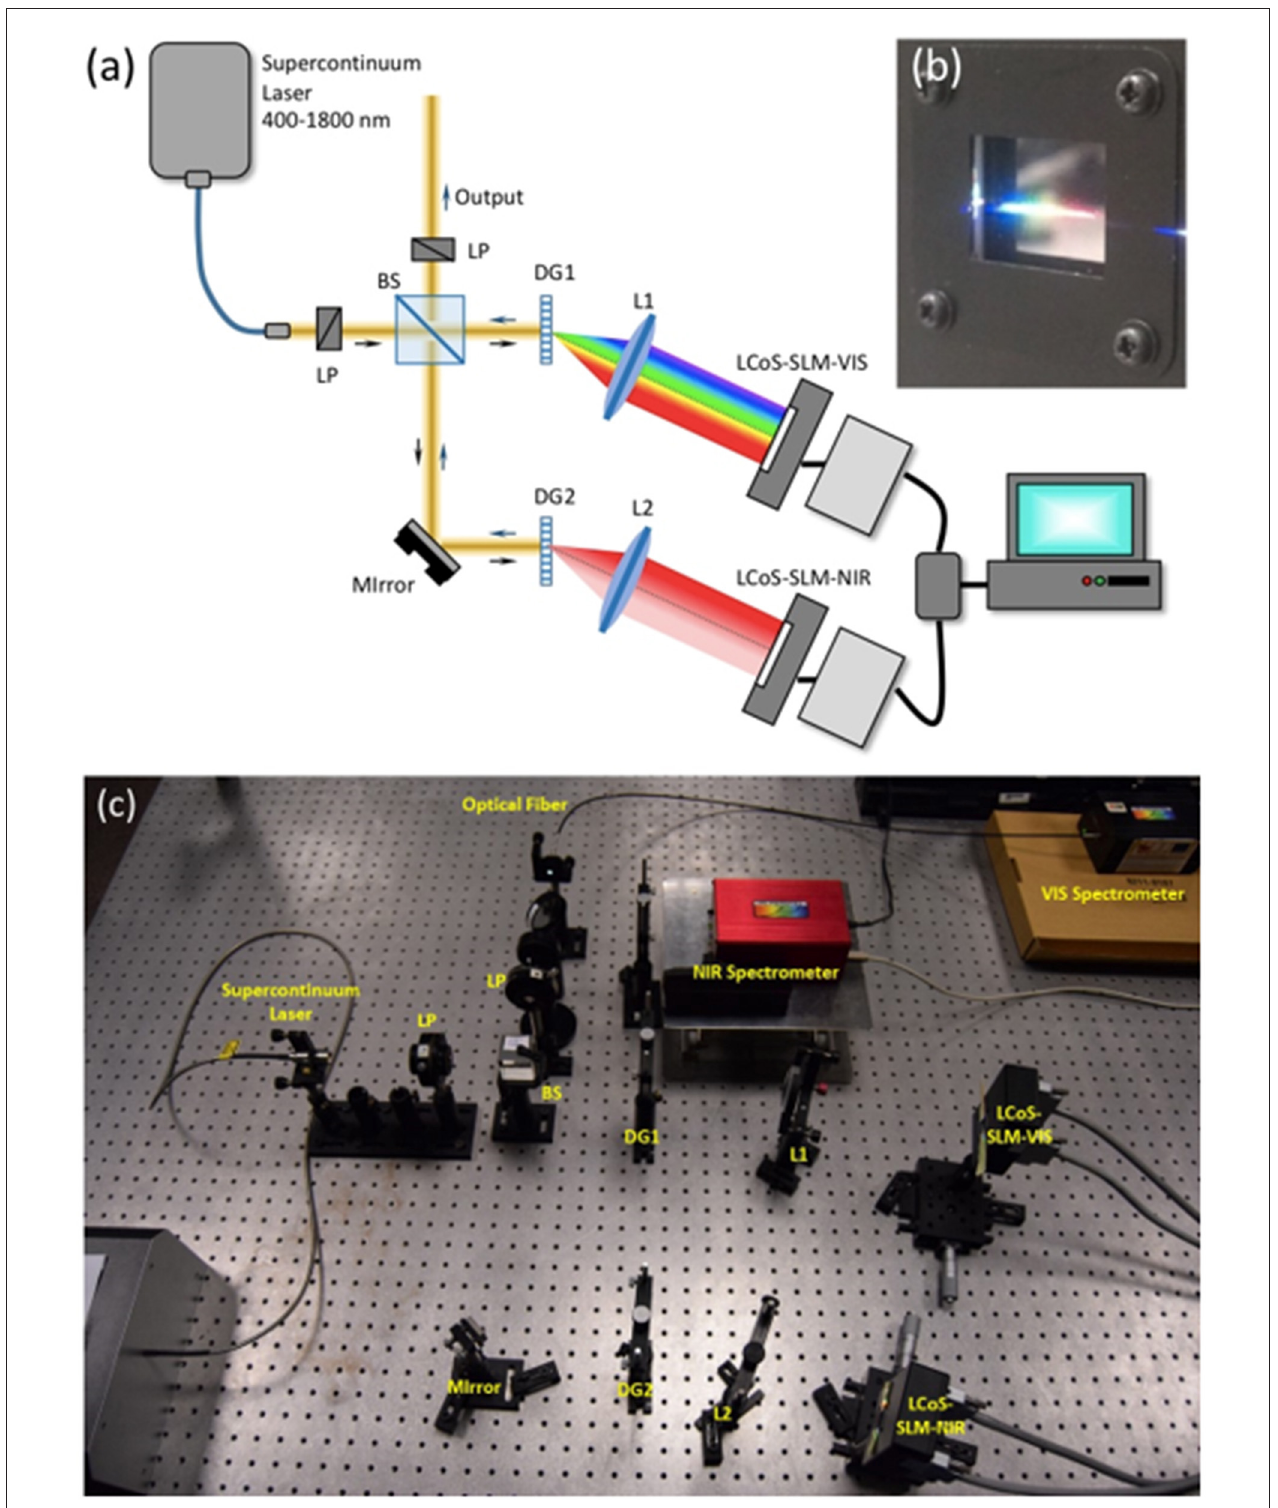
FIGURE 1 | (a) Scheme of the VIS-NIR spectrum generator; LP, linear polarizer; BS, beam-splitter; DG, blazed diffraction grating; L, converging lens. (b) Picture of the dispersed visible SC beam projected onto the VIS-LCoS-SLM. (c) Picture of the complete system.